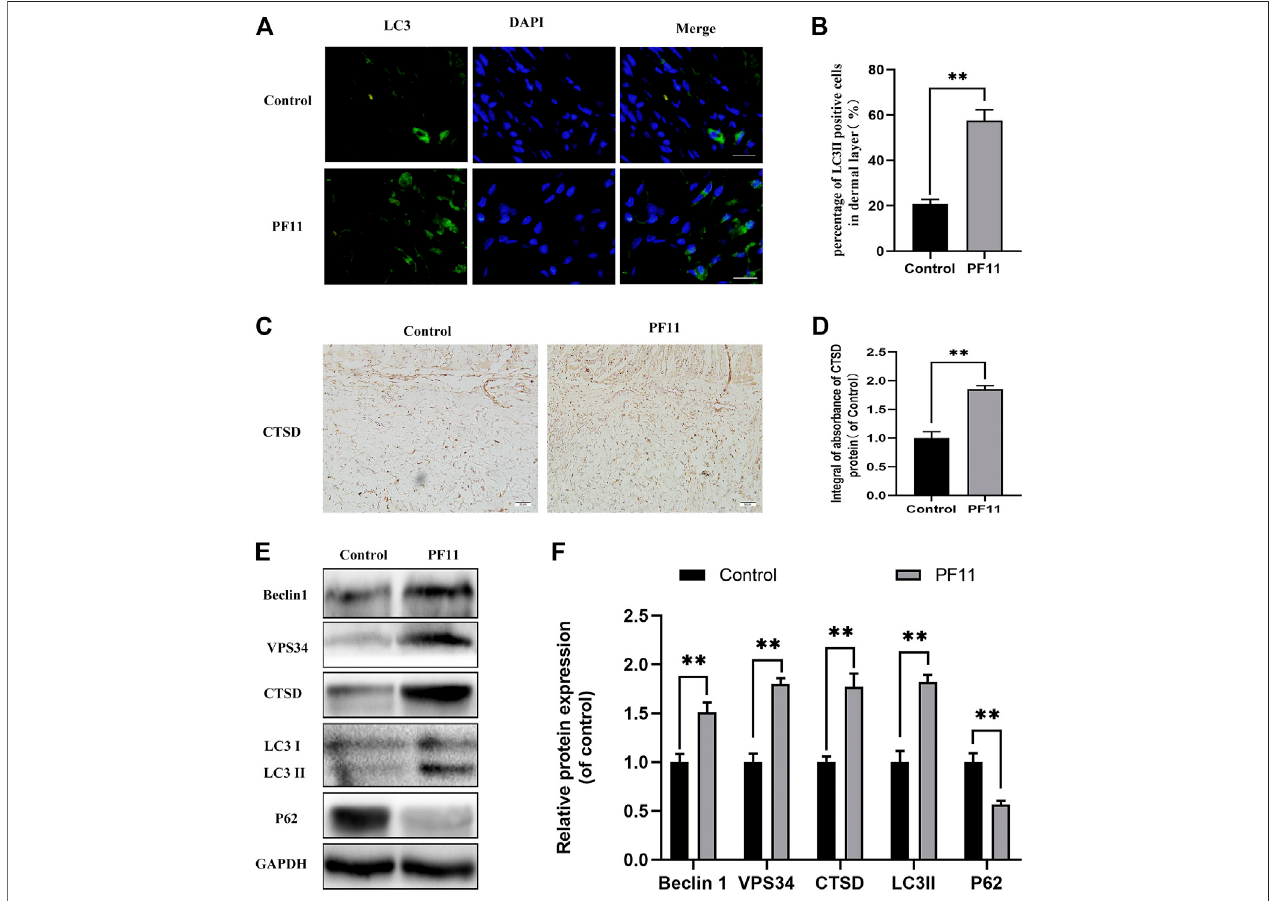
FIGURE4| PF11increasedautophagy fl uxinrandomskin fl aps. (A) Resultsofimmuno fl uorescencestainingforLC3IIpositivecellsinthedermallayershowingthe autophagosomes (red) in cells in Area II of fl aps (scale bar: 20 μ m). (B) Histogram showing the percentages of LC3II positive cells. (C) IHC results showing the level of CTSD in the control and PF11 groups (scan bar, 50 μ m). (D) The integral absorbance of CTSD protein in the dermal layer. (E,F) Results of western blotting showing the expression of Beclin1, VPS34, CTSD, p62, and LC3II. Values are expressed as means ± SD, n (cid:2) 6 per Group. * p < 0.05 and ** p < 0.01, vs. control group.